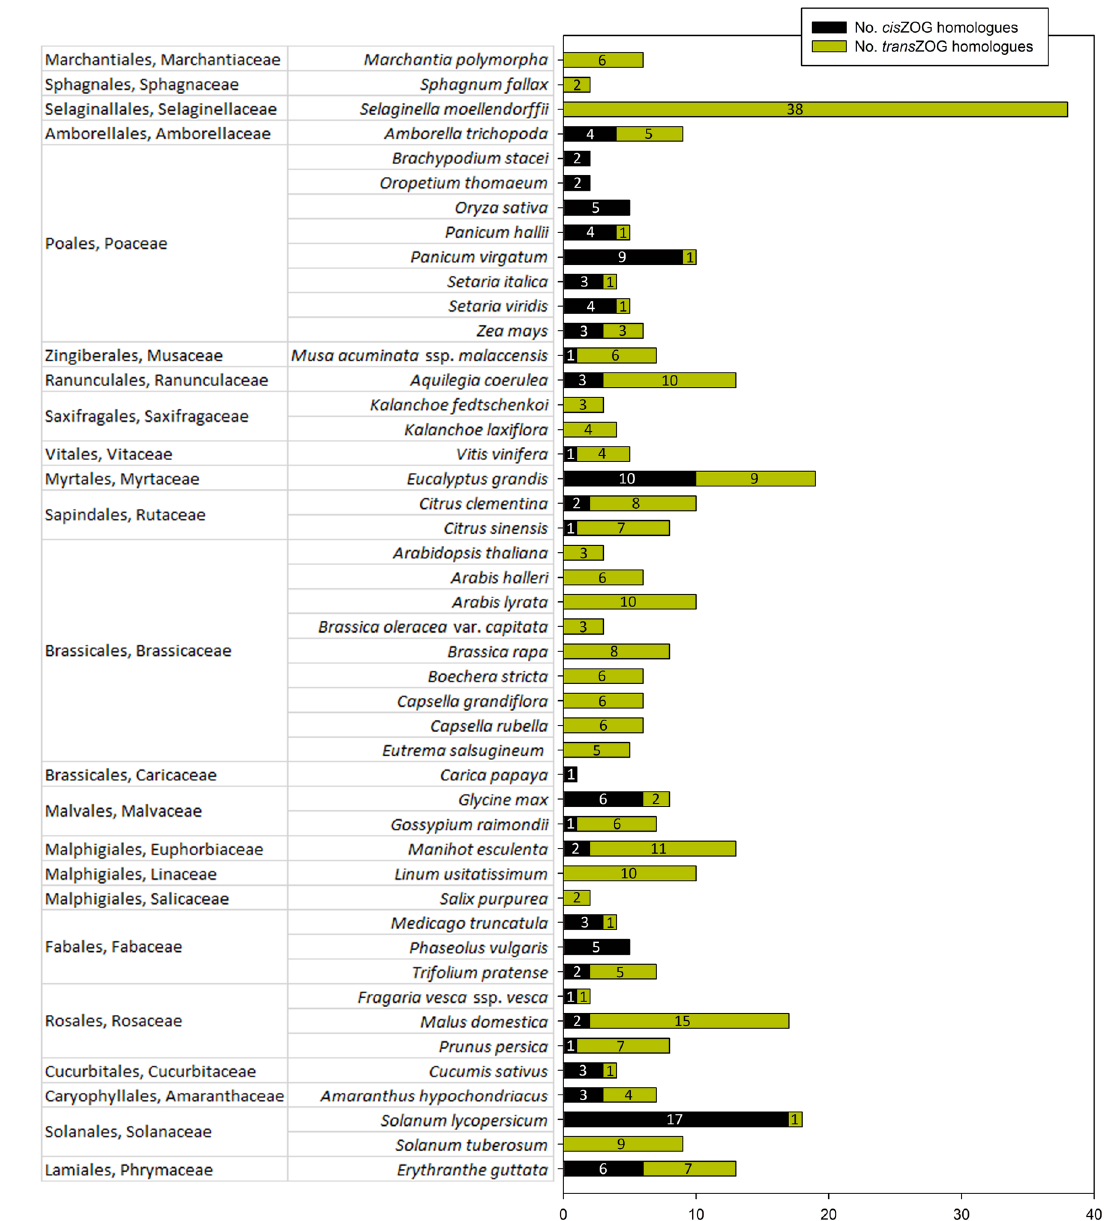
Figure 2. Quantity of cis - and trans ZOG homologs of angiosperm species from complete genomes (Phytozome v. 12) sorted by phylogenetic system. Species from bryophytes ( Marchantia polymorpha, Sphagnum phallax ) and lycophytes ( Selaginalla moellendorffii ) are shown for comparison with